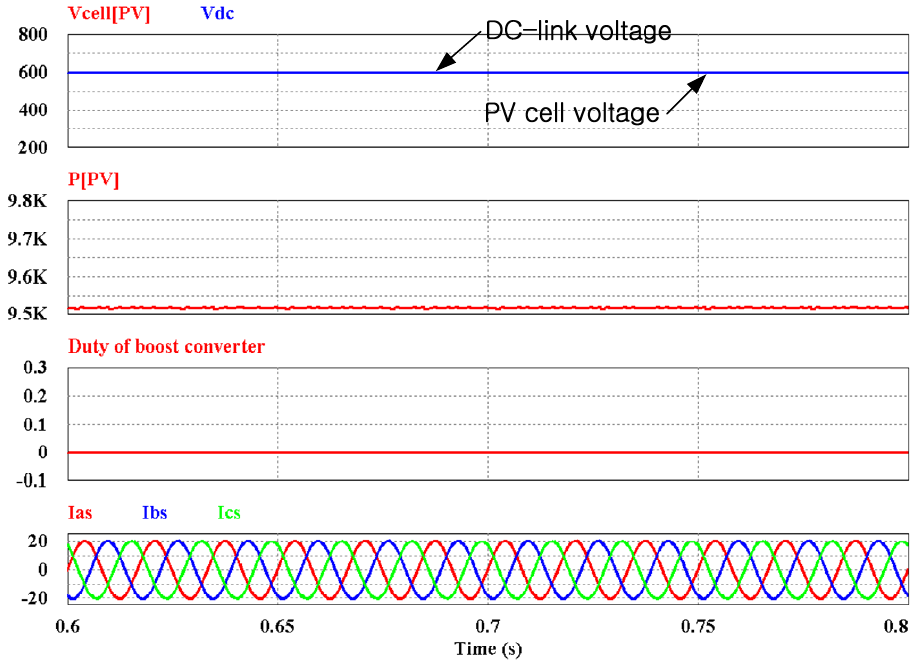
Figure 8. Simulation results: MPP is 655 V and the DC-link reference voltage is 600